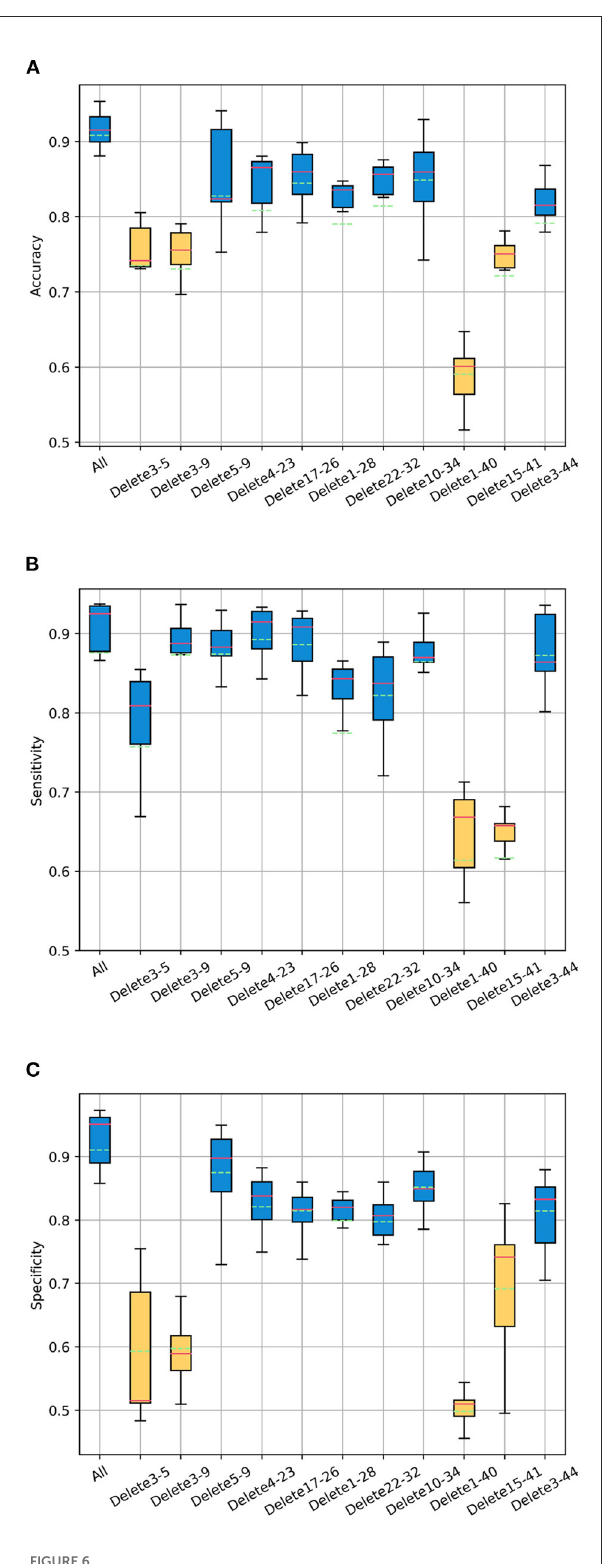
FIGURE6 The changes of the ASD classification effect after deleting the edges between channel pairs. Boxplots represent the variant of classification (A) accuracy, (B) sensitivity, and (C) specificity of test sets in multiple epochs during training. The abscissa “All” represents no edges are deleted. The abscissa “Delete 3–5” represents deleting the edges between channel 3 and channel 5, and so on.